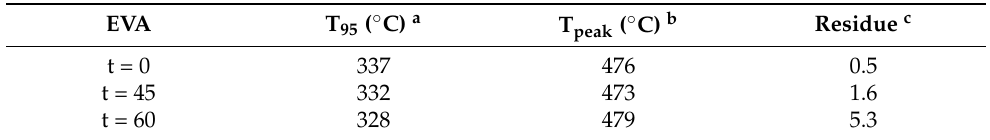
Table 2. Onset temperatures of degradation, temperatures at maximum rate of decomposition and residual masses of EVA + LDH 5% at 0, 45 and 60 days of exposure.